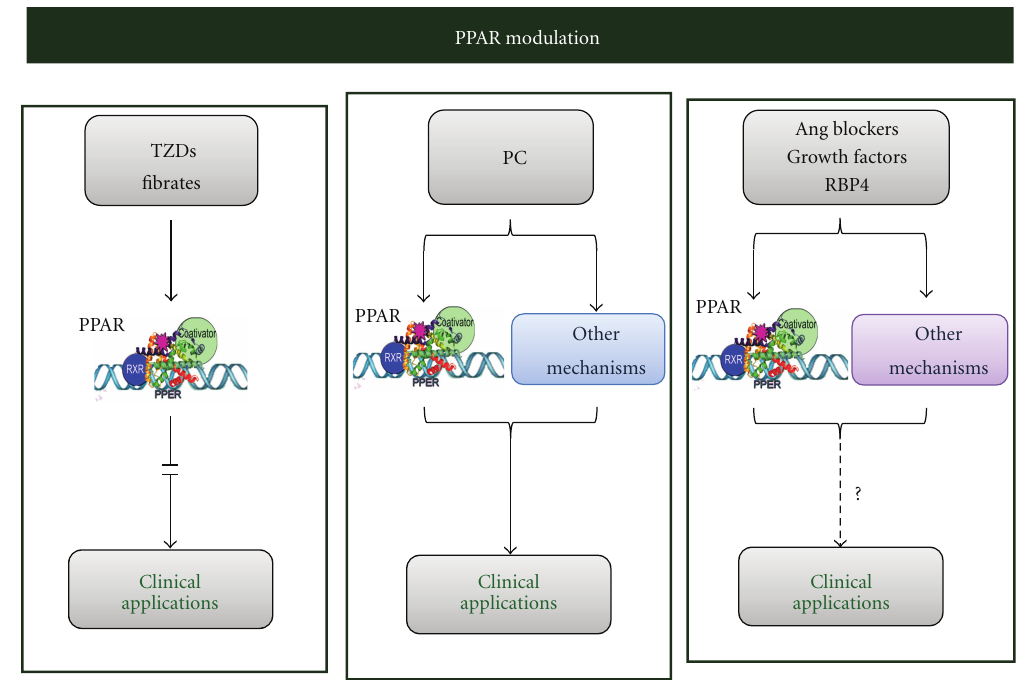
Figure 4: Clinical application of strategies that regulate PPARs. Angiotensin: Ang; peroxisome proliferator-activated receptors: PPARs; ischemic preconditioning: PC; retinol binding protein: RBP4; thiazolidinediones: